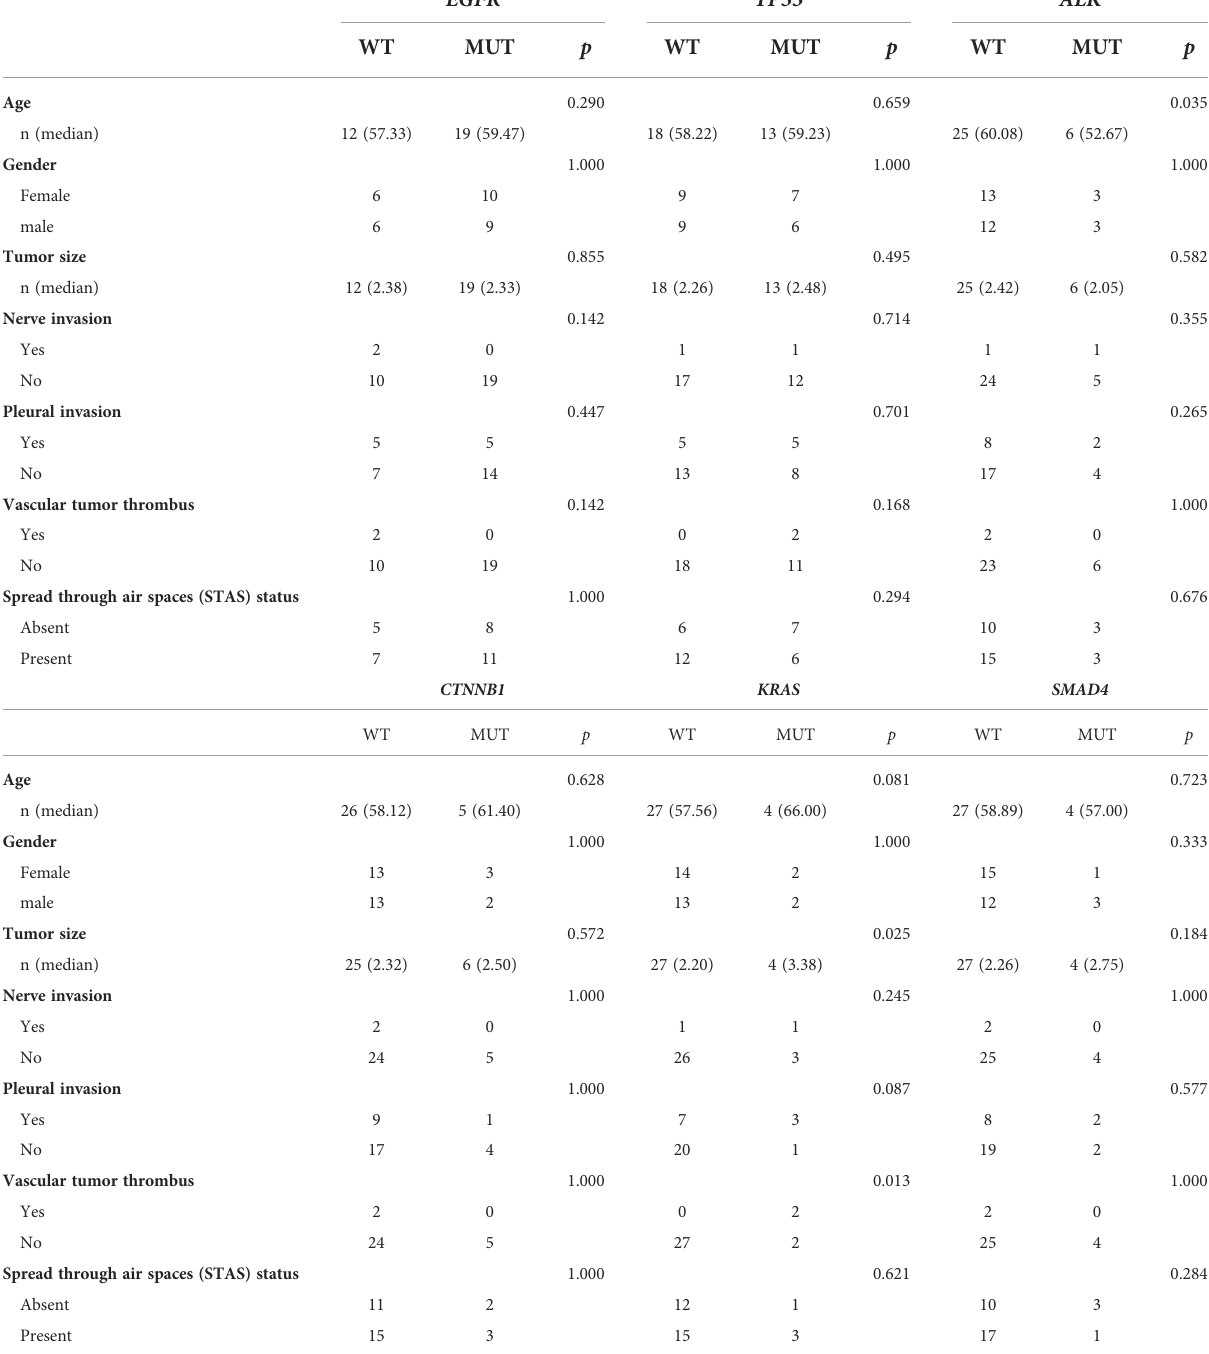
TABLE 5 Correlation analysis between major driver gene variants and clinical characteristics in patients with MPC.